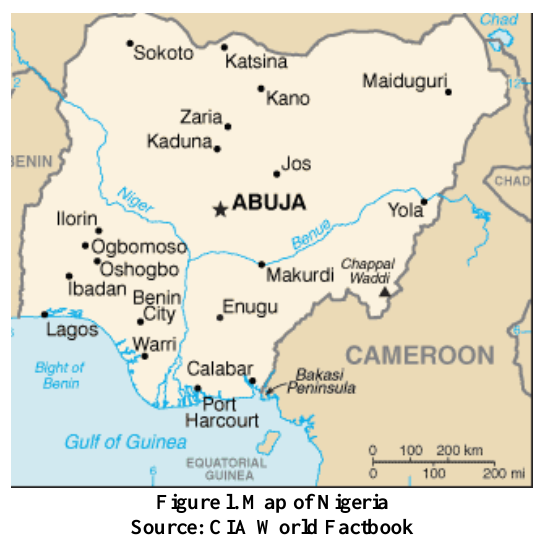
Figure l. Map of Nigeria Source: CIA World